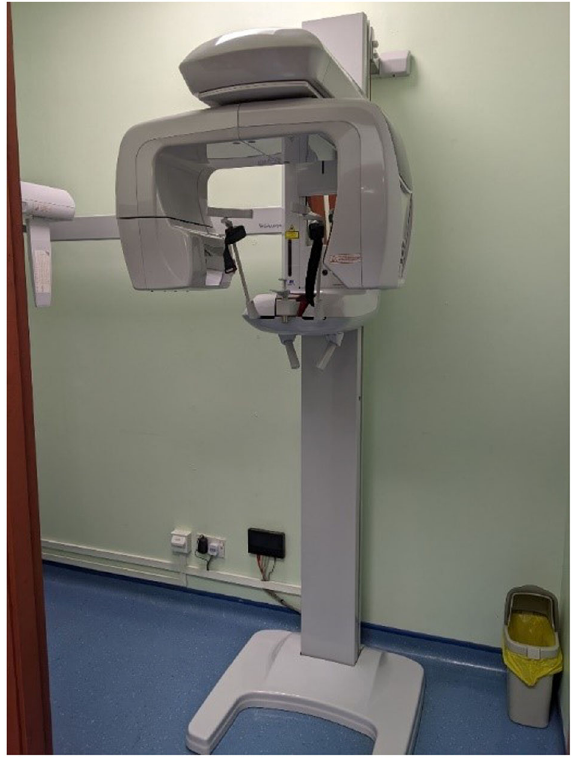
Fig. 1 CBCT scanner. CBCT scanner used in the study which is located in the National Dental Centre, Brunei Darussalam.